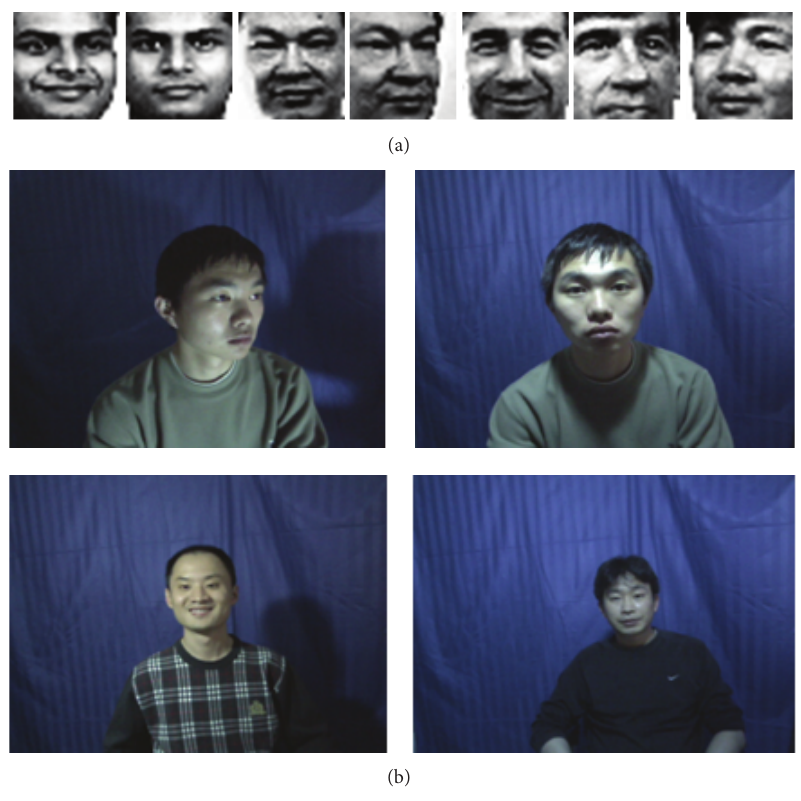
Figure 4: Sample face images from (a) YALE [5] and (b) CASIA [6] databases.